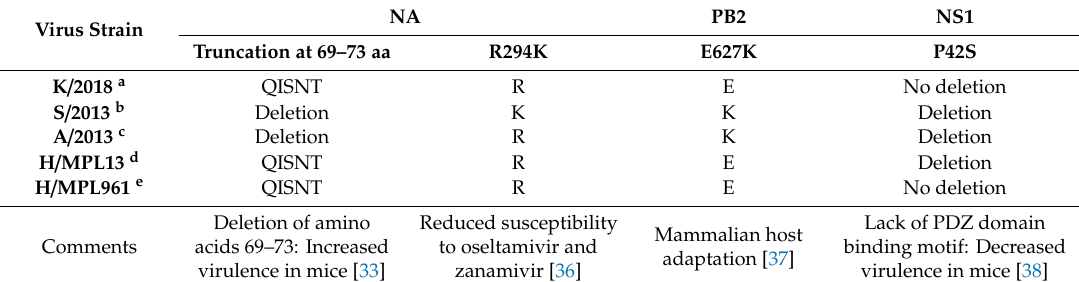
Table 4. Genetic analysis of the NA and internal gene of